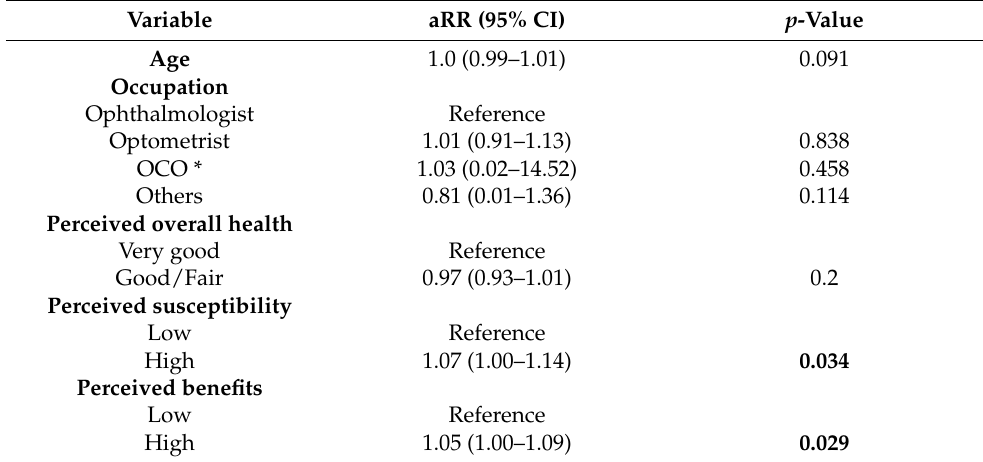
Table 4. Multivariable analysis of factors associated with COVID-19 vaccine acceptance among eye health workers in Uganda.